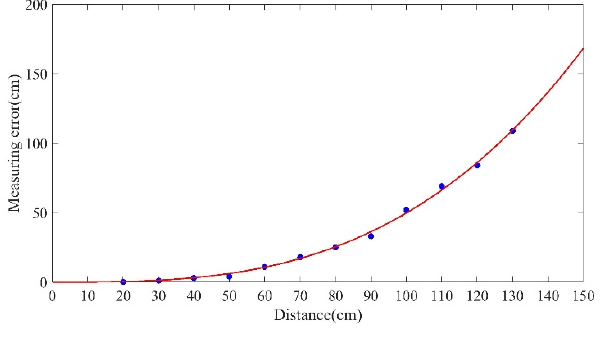
Figure 21. Fitting results.